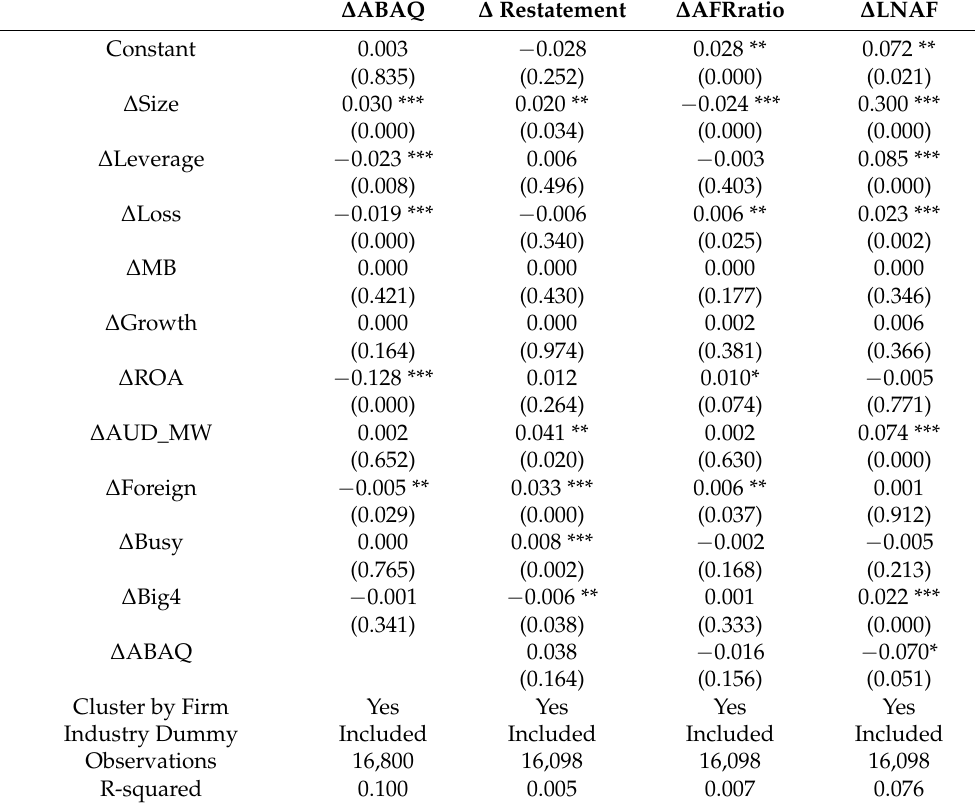
Table 5. Cont. Panel B: Three-year balanced panel designed ABAQ, Restatement, and AF of U.S. sample firms. ∆